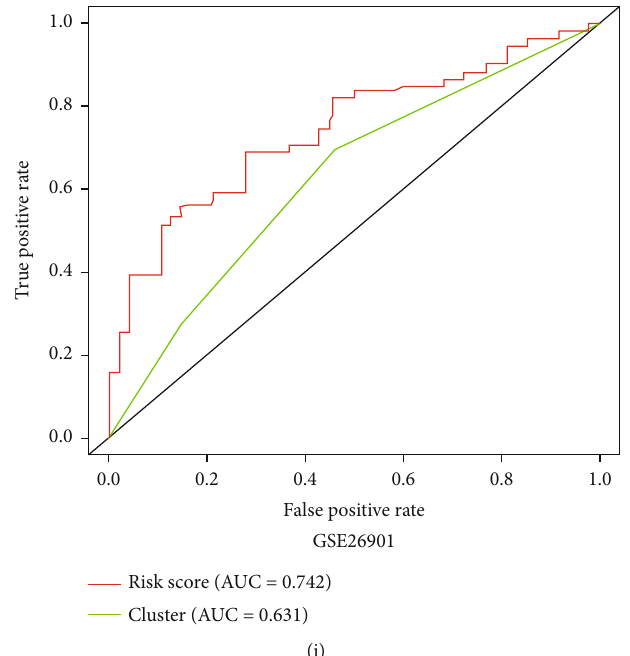
Figure 4: Internal validation of the prognostic signature. (a – c) Kaplan – Meier survival analysis and the time-dependent ROC analysis of the risk score and gene cluster for predicting OS in the GSE62254 cohort. (d – f) Kaplan – Meier survival analysis and the time-dependent ROC analysis of the risk score and gene cluster for predicting OS in the GSE15459 cohort. (g – i) Kaplan – Meier survival analysis and the time- dependent ROC analysis of the risk score and gene cluster for predicting OS in the GSE26901